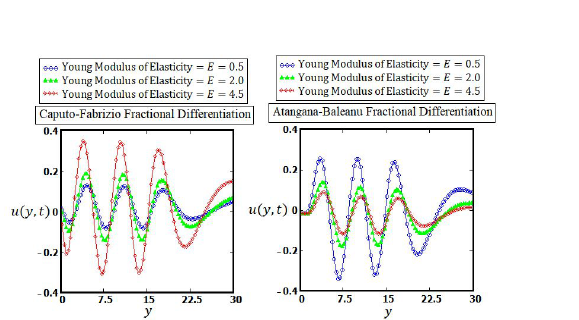
Figure 4: Graph of displacement via CF and AB fractional operator with three different variants of young modulus of elasticity E .